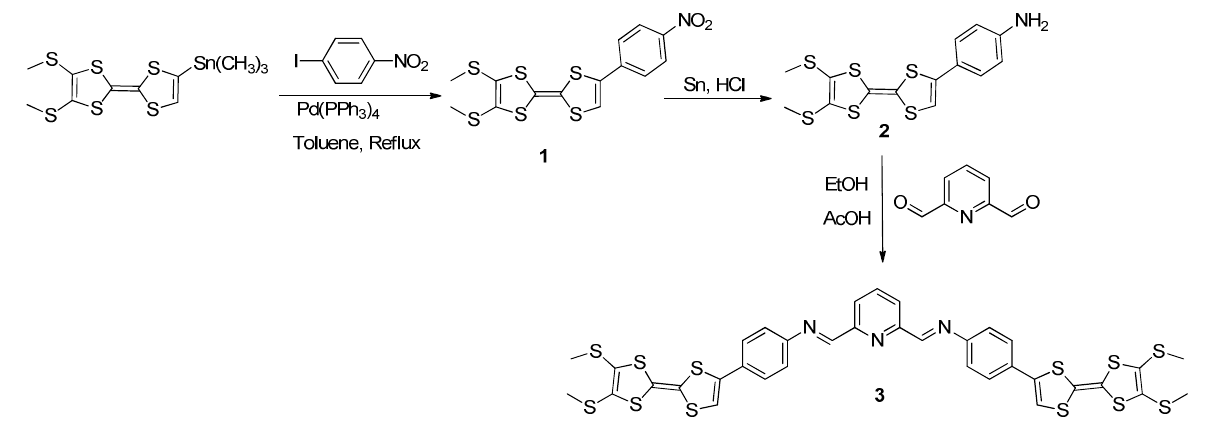
-BisIm-Py Pincer ( 3 2